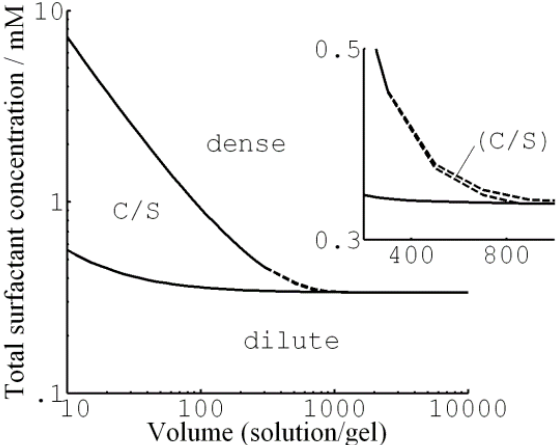
Figure 13. Calculated equilibrium state of the gel upon addition of surfactant to the system. Concentration of simple salt is 10 mM. Volume is the ratio of the volume of the solution to the volume of the gel when it is equilibrated in a large solution of 10 mM of simple salt. C / S denotes phase coexistence between a dense shell and a dilute core. The narrow (C / S) area, enhanced in the inset, is metastable core–shell. Figure taken from ref. [74]. Reprinted with the permission of AIP Publishing.